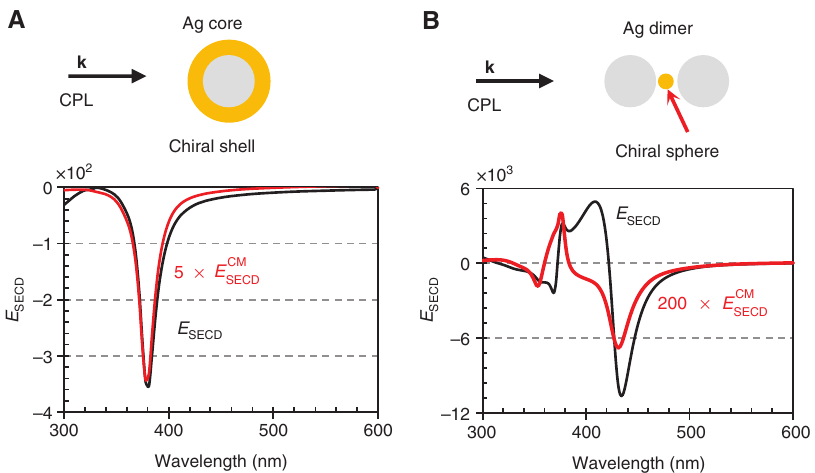
E (red) of (A) a spherical chiral shell enclosing an Ag (black) and CM SECD SECD